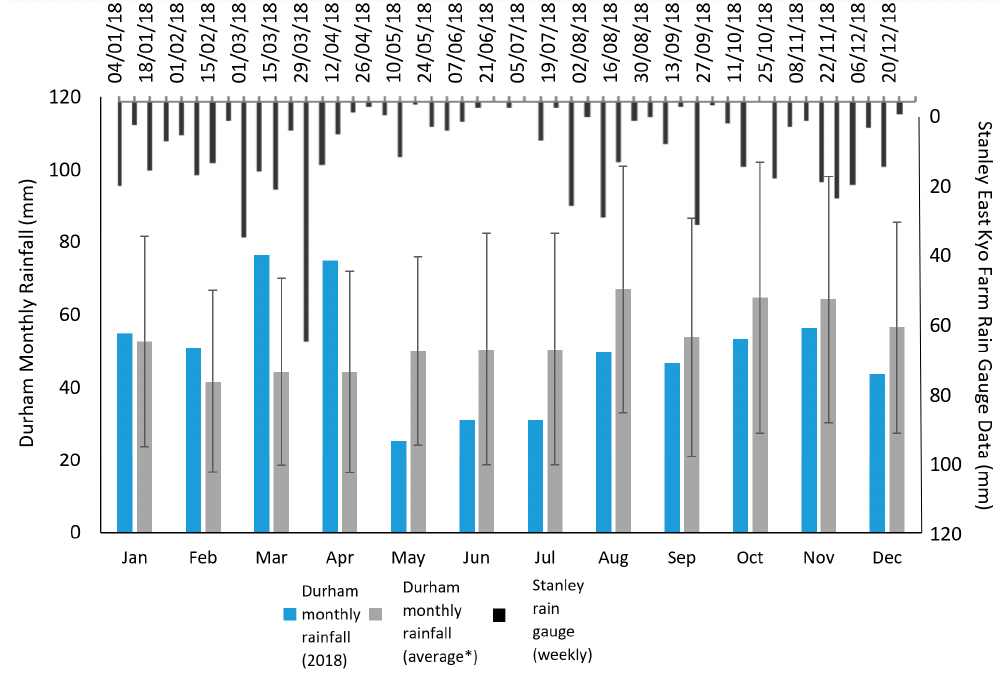
Figure 7. Total monthly rainfall (mm) in Durham in 2018 compared to average Met Office UK climate- historic station data (1880–2018) (primary x -axis) [40], and weekly total rainfall (mm) from Stanley East Kyo Farm rain gauge (secondary x -axis) [41]. The Stanley rain gauge is the nearest Environment Agency telemetered rain gauge to South Moor, where the data are reported from a tipping bucket rain gauge as accumulated totals for each 15 min period and summed per time interval [41].